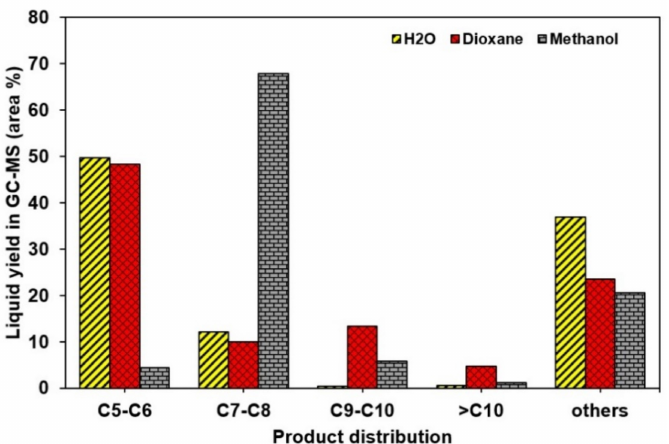
Figure 8. Effect of solvent on the high value chemical (HVC) liquid fraction yield after 6 h at 300 ◦ C under 2 bars initial N 2 pressure with 5 wt% commercial NiAl, 2 g biomass, methanol solvent, and biomass particle size of 180 µ